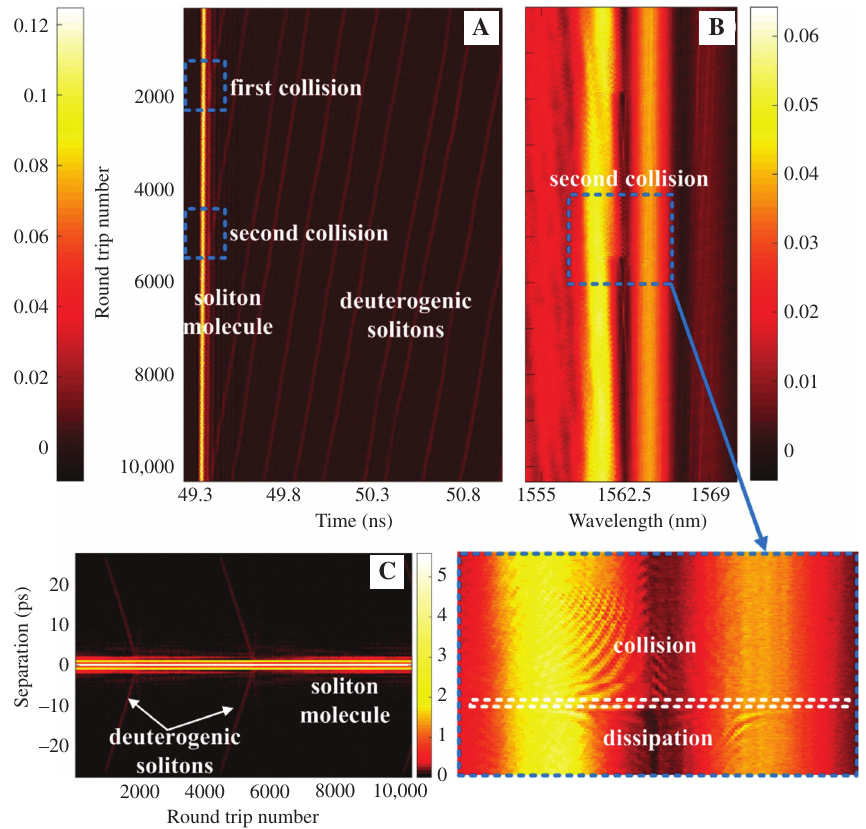
Figure 7: The spectral-temporal dynamics of soliton collision. (A) Spatio-temporal map of soliton collision at a pump power of 200 mW. (B) Corresponding spatio-spectral evolution based on TS-DFT technique; bottom inset: the zoom-in spectral view. (C) Field autocorrelation of each single-shot